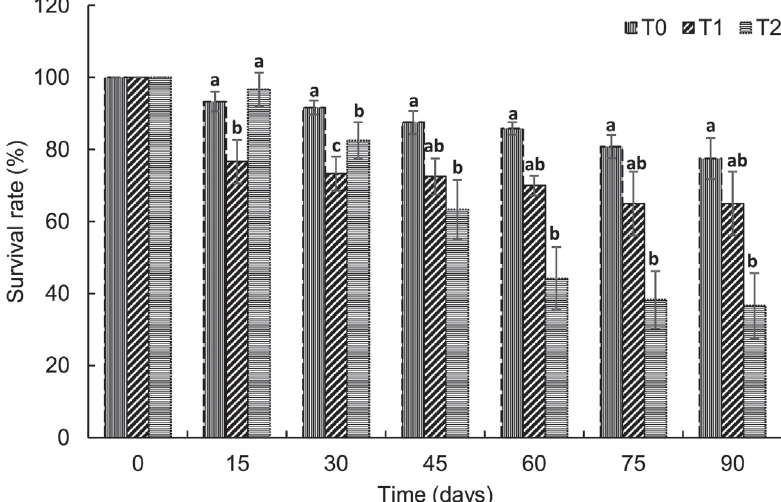
Fig. 1. Variation in the survival rate of Macrobrachium amazonicum juveniles across the 90-day culture at different temperatures (T0: 28± 0.5 ° C, T1: 30± 0.2 ° C, T2: 32 ±0.5 ° C). Mean values followed by the same letters between column indicate no difference according to Dunn test ( P <